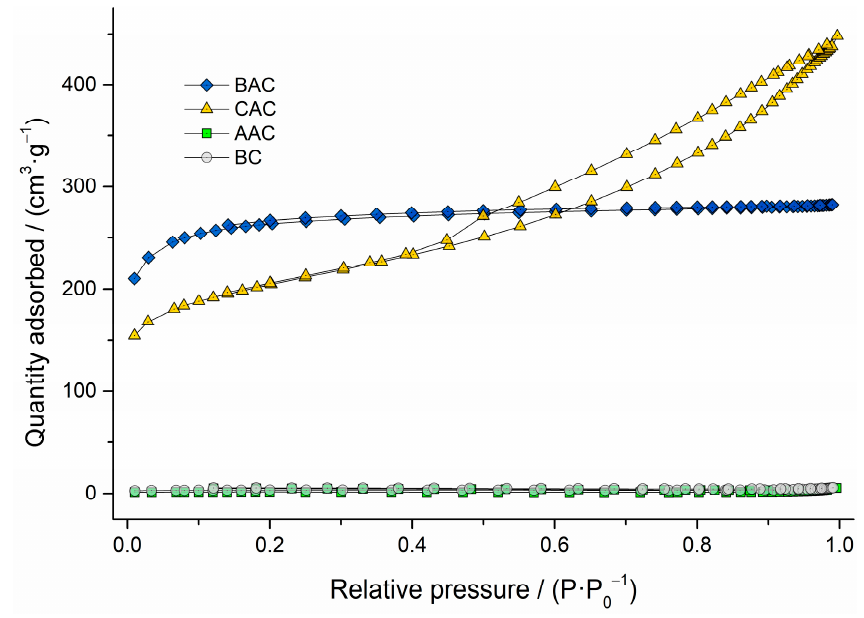
Figure 1. N 2 adsorption isotherm of the materials. Table 3. Results of the textural analysis of the four materials.